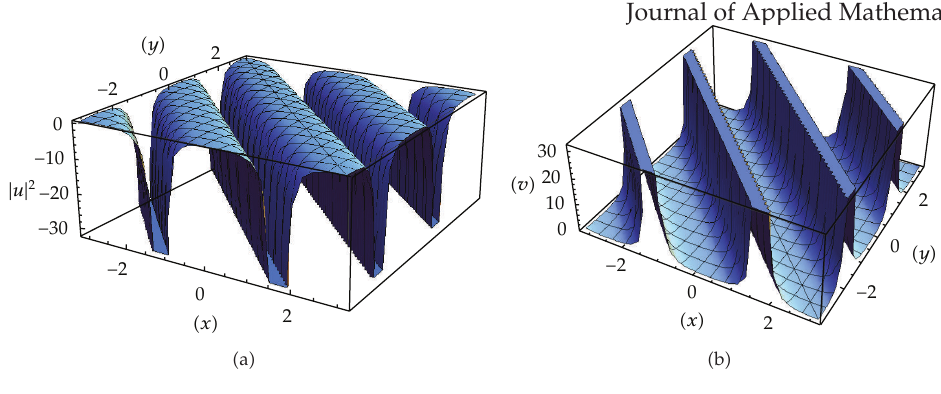
Figure 2: Profile of the solution (cid:3) 3.12 (cid:5)